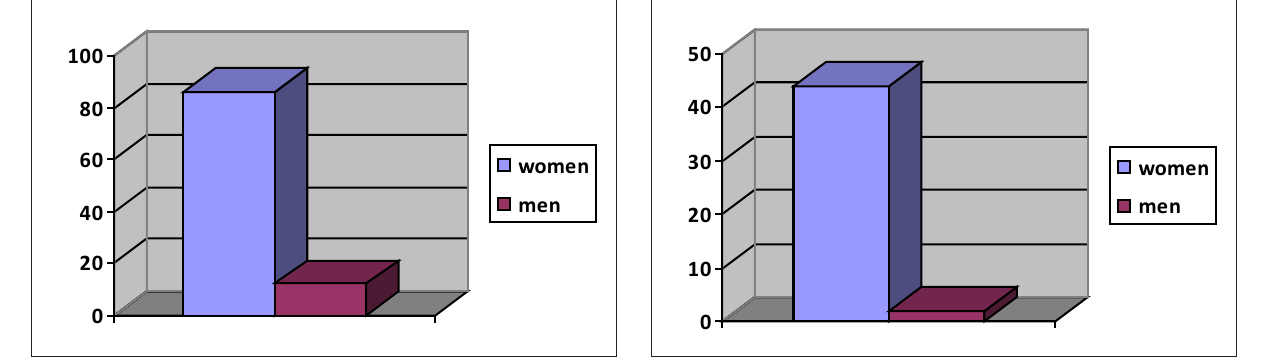
Fig. 2. Good treatment outcome (men/women). Fig. 3. Treatment without any effect